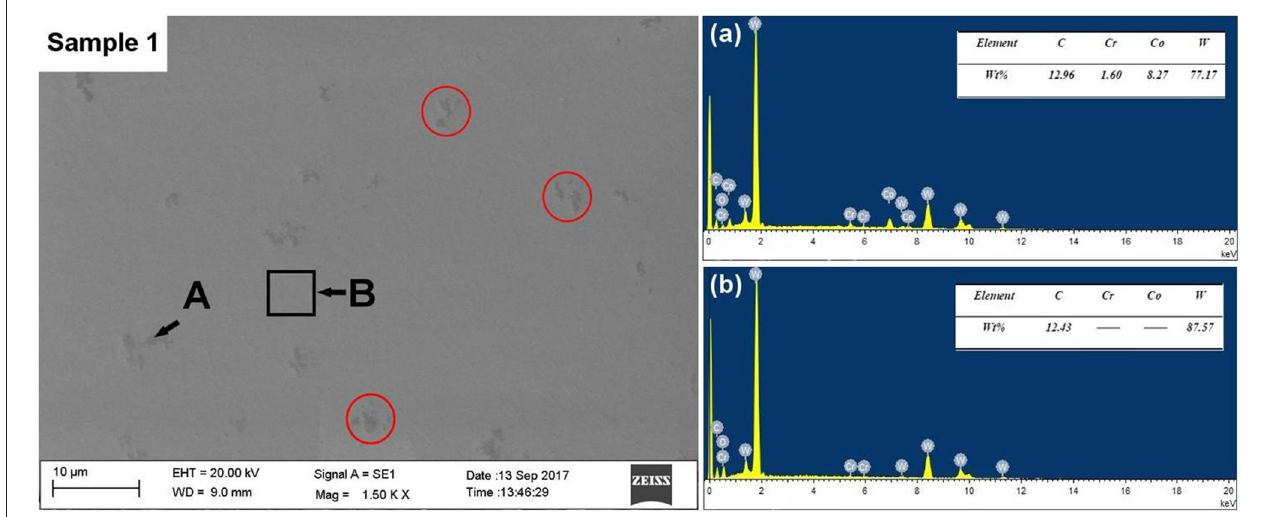
FIGURE 5 | SEM microstructure and EDX results of certain areas on the polished surface of sample 1: (a) Point A; (b) Area